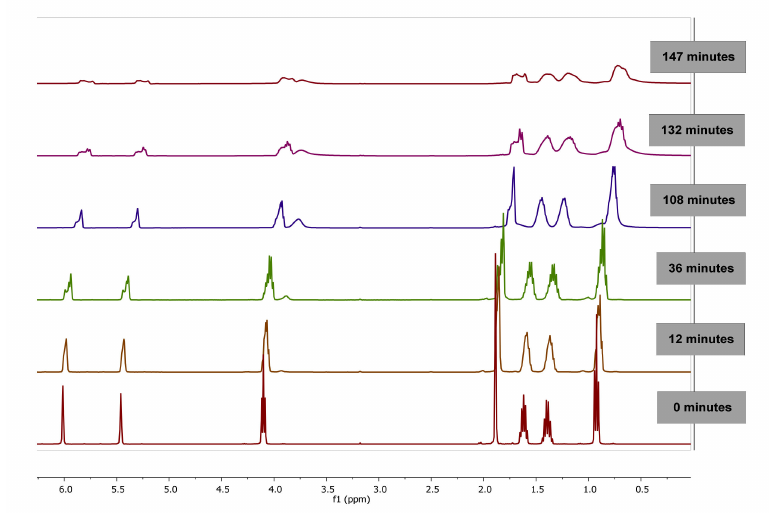
Figure 3. 1 H-NMR Spectra of poly(butyl methacrylate) (PBMA) obtained by bulk polymerization at 60 ◦ C at different reaction time, using CDCl 3 -d.